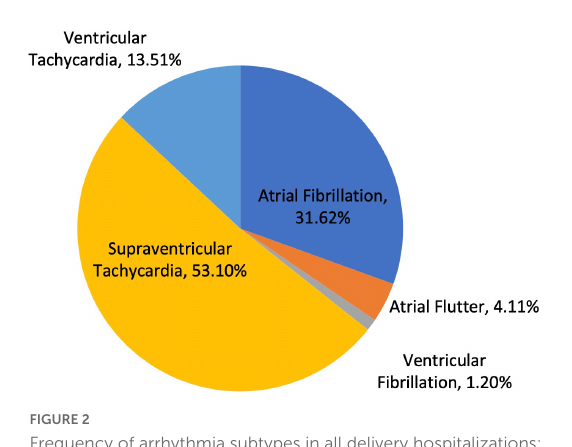
FIGURE2 Frequency of arrhythmia subtypes in all delivery hospitalizations; specifically atrial fibrillation, atrial flutter, supraventricular tachycardia, ventricular tachycardia, and ventricular fibrillation.